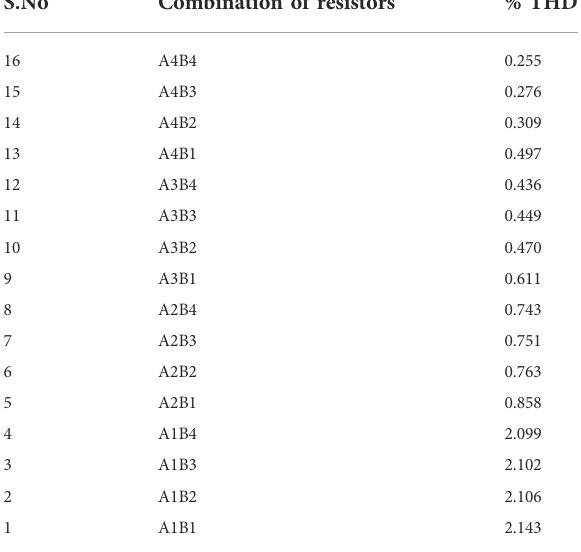
TABLE 5 Dynamic method of